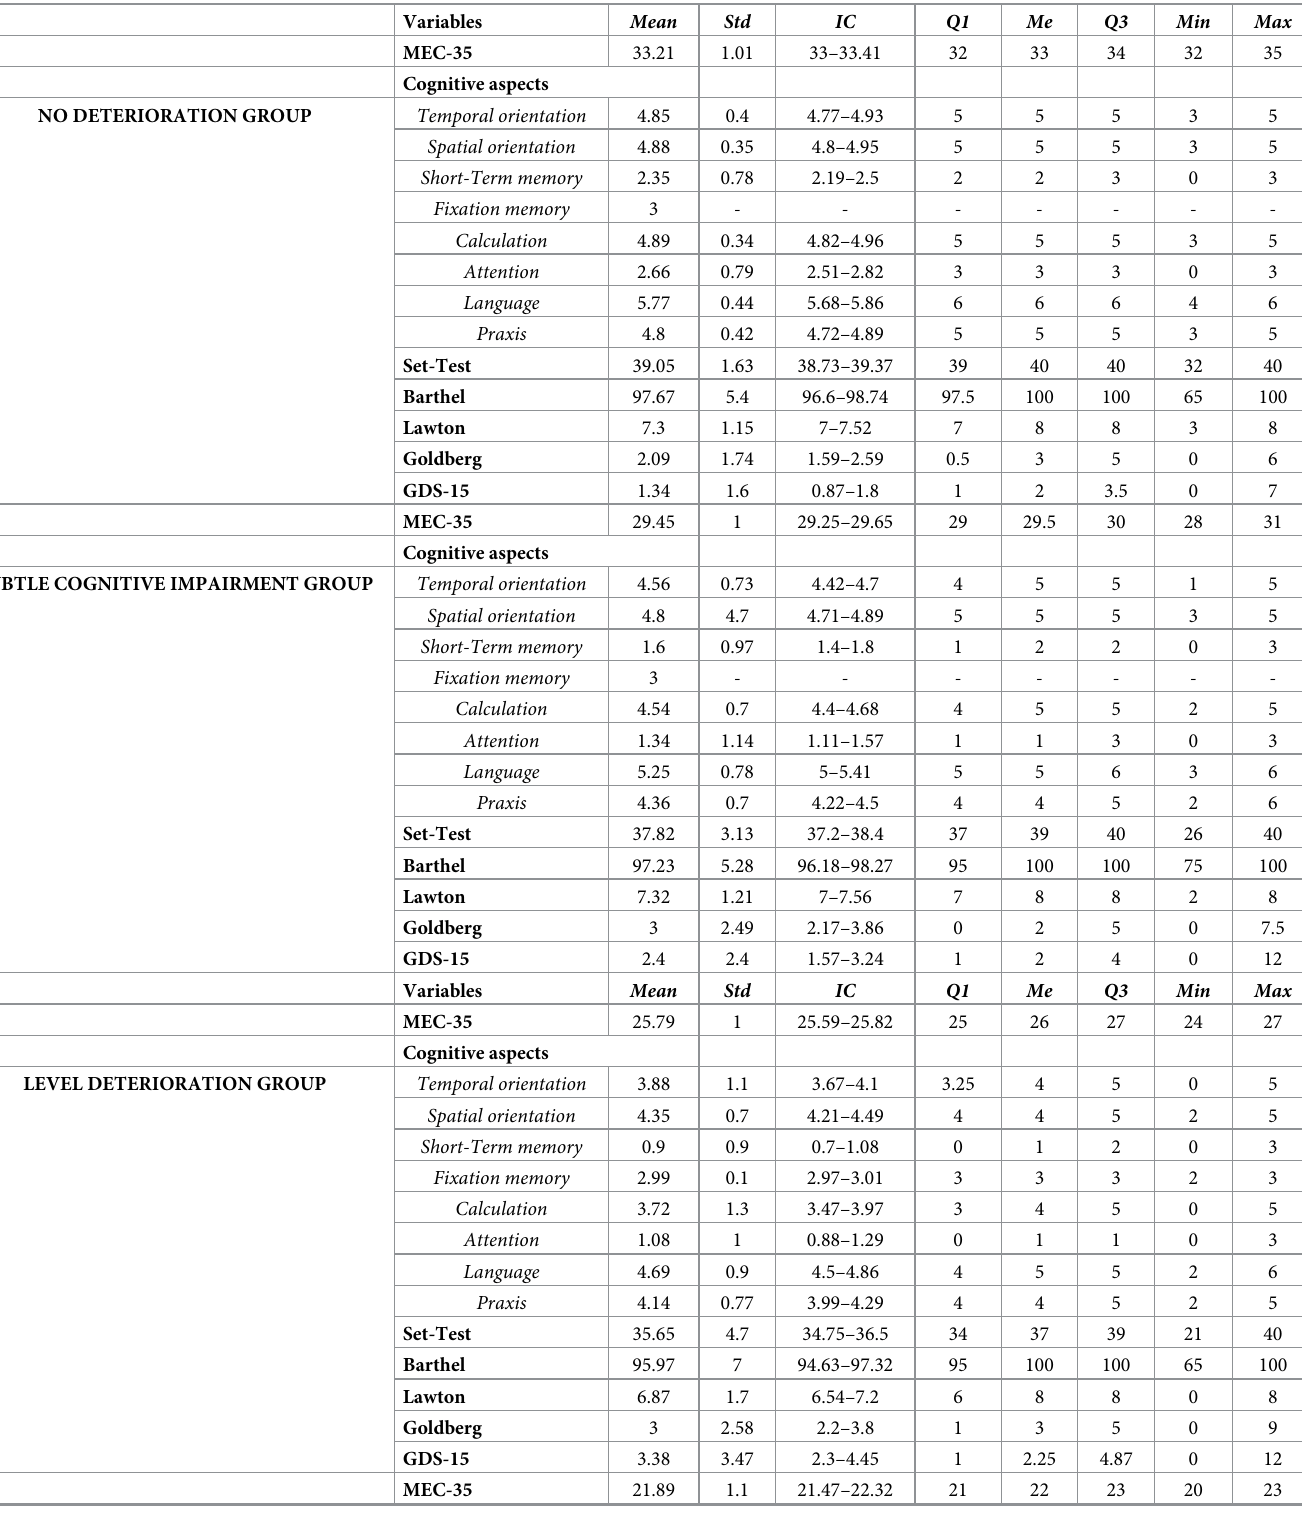
Table 2. By levels, descriptive of the quantitative